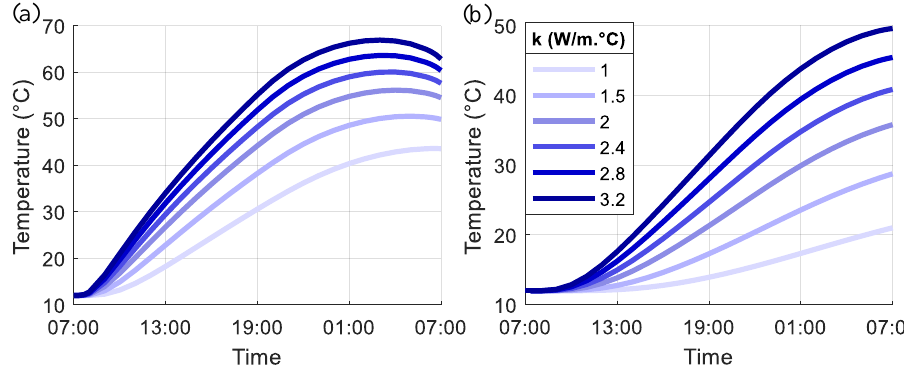
Figure 16. Temperature change in the first loading cycle for different k at: ( a ) the midpoint of the pile section; ( b ) the outer surface of the pile section.